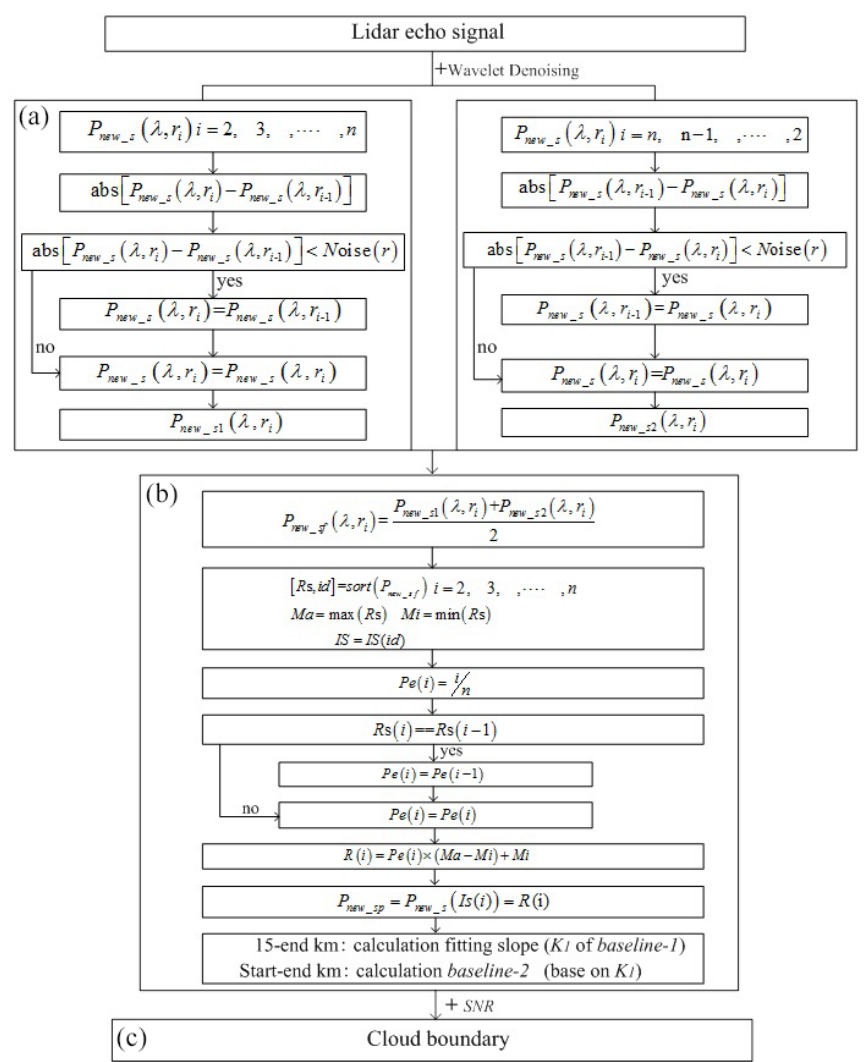
Figure 2. Use lidar to detect cloud boundary. (a) Signal preprocessing, (b) baseline determination based on enhanced signal, and (c) identi- fying cloud boundary with